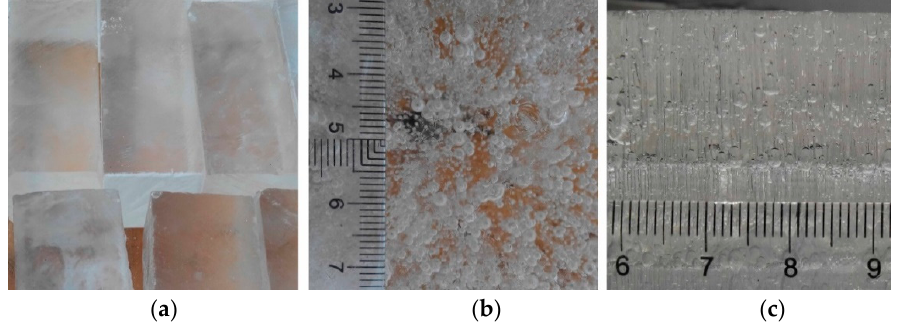
Figure 1. ( a ) Hard ice harvested during the stable freezing season and does not contain naked-eye visible air bubbles, with an average air porosity of 0.1%; and soft ice (( b ) vertical view; and ( c ) side view) harvested in early melting reason and contains lots of slender air bubbles, with an average of air porosity of 2.0%.